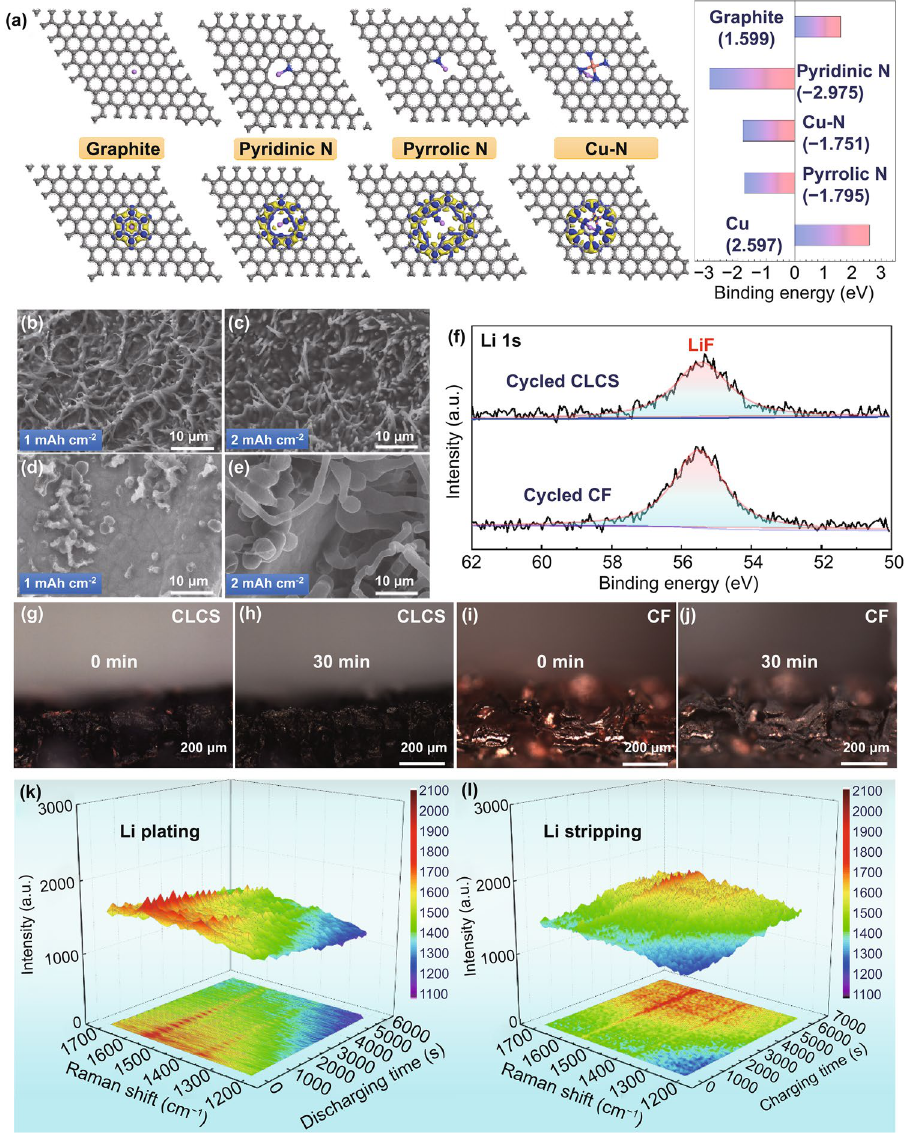
Fig. 3 a Density functional theory calculations on the adsorption energy between Li atoms and graphite, pyridinic N, pyrrolic N and Cu–N site. Moreover, values of related adsorption energy for these groups are calculated. SEM images of CLCS loading with Li deposition of b 1 mAh cm −2 and c 2 mAh cm −2 . SEM images of CF plating with metallic Li of d 1 mAh cm −2 and e 2 mAh cm −2 . f XPS survey spectra of CLCS and CF electrode after 50 cycles. In situ optical observation of CLCS at the discharging time of g 0 min and h 30 min. In situ optical images of CF at the discharging time of i 0 min and j 30 min. In situ Raman spectra of CLCS at k Li plating and l Li stripping